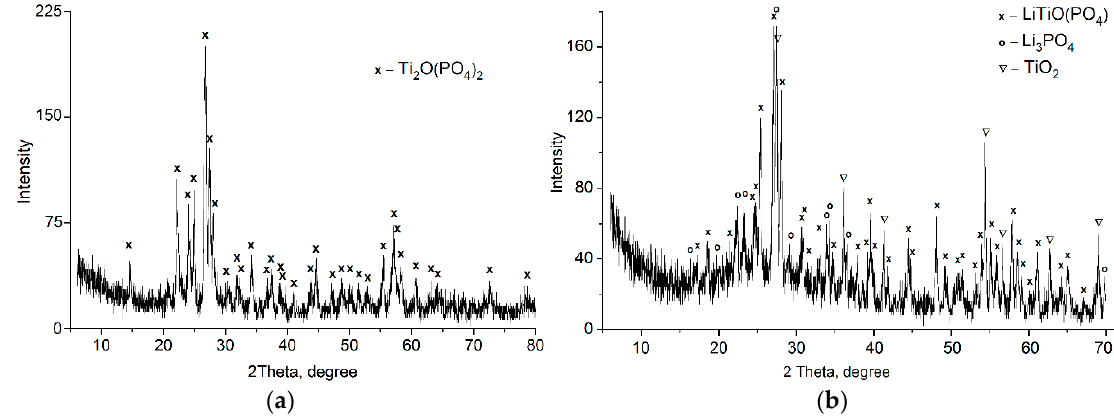
Figure 1. XRD powder patterns of TiOP ( a ) and Li-TiOP ( b ) products calcined at 750 ° С .